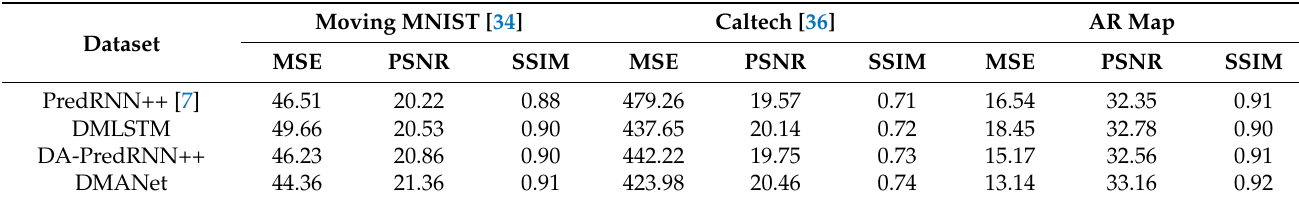
Table 2. Ablation study in different methods.